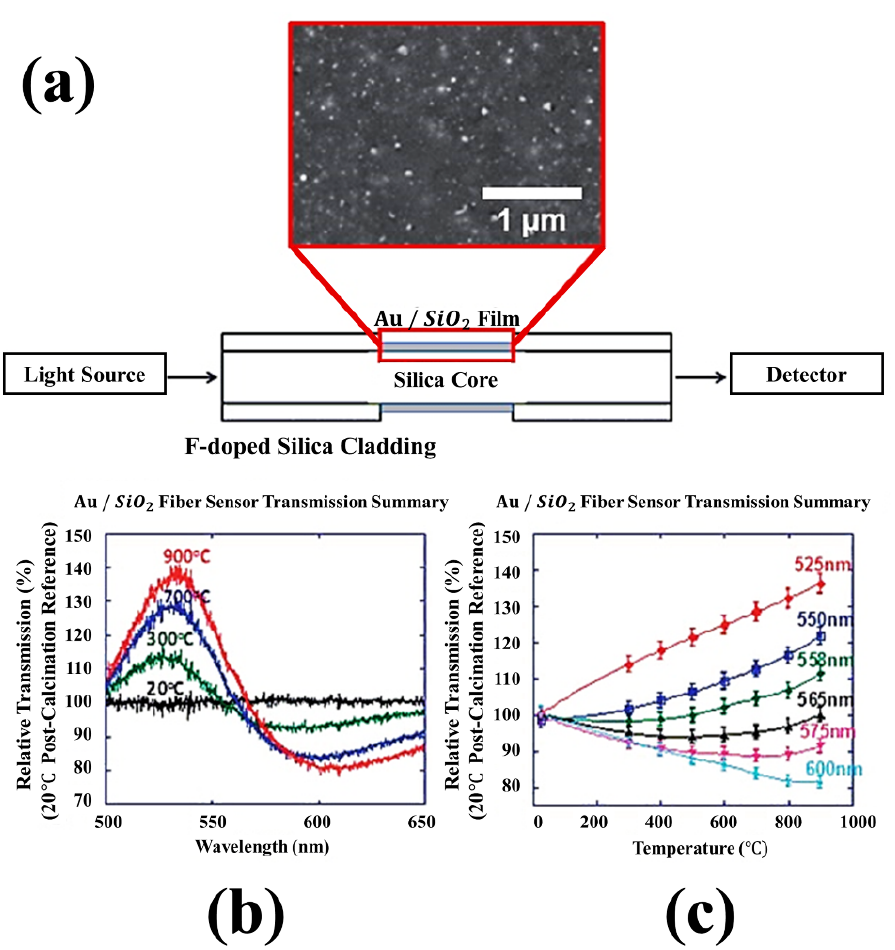
Figure 8. ( a ) Schematic of a fiber-optic temperature and gas sensor that is capable of operating in extreme temperature conditions. The inset figure shows the scanning electron microscopic image of Au/SiO 2 nanocomposites fabricated on the fiber-optic temperature and gas sensor. ( b ) Trans- mission spectra measured by the fiber-optic temperature and gas sensor at 20, 300, 700, and 900 ◦ C. ( c ) Relationship between the temperature and relative transmission according to wavelength of the light source introduced in the fiber-optic sensor. The figure in Ohodnicki et al. [69] is reprinted with permission from Royal Society of Chemistry (RSC).